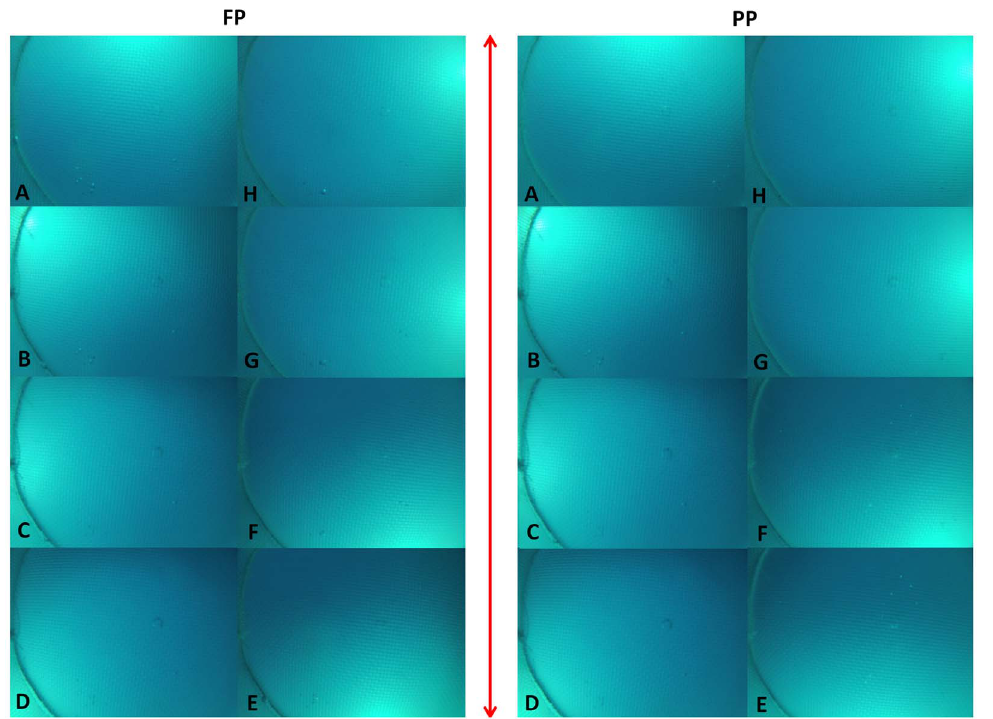
Figure 3. View from the behavioral chamber looking upwards, under full and partial polarization (FP and PP, respectively). The DISC was manually rotated 360 u counterclockwise, at increments of , 45 u (A–H), while scuba-diving at a depth of 9 m. Red arrow indicate the filter’s e- vector orientation. Photos were taken on the 18 th of November 2013 at 14:35–14:50. Solar elevation at the time was approximately 21 u from the horizon, and the sky was clear.